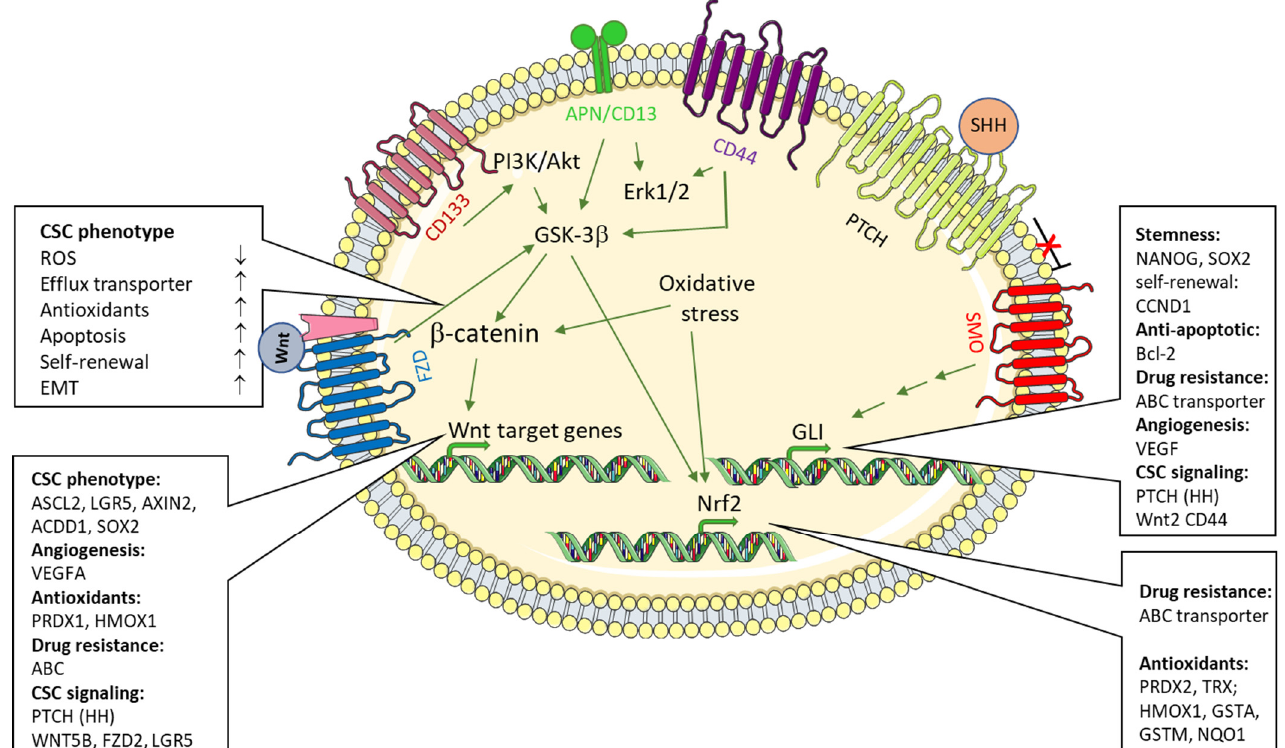
Figure 1. Pathways contributing to the maintenance of the cancer stem cell (CSC) phenotype. Keeping intracellular ROS levels low is required for a stem cell to maintain quiescence and self-renewal properties. This is achieved to a large extent by expression of Nrf2-induced target genes. Thereby, antioxidative defense molecules and detoxifying enzymes including thioredoxin, peroxiredoxin, glutathione-S-transferases, heme oxygenase I are provided to keep the levels of reactive oxygen species derived from, e.g., NADH oxidases (NOX), the respiratory chain, infiltrating/surrounding immune cells, or chemotherapeutic drugs low. Nrf2 and pathways initiated by the CSC surface receptors and markers to minimize ROS production in response to chemotherapeutics like Sonic Hedgehog, Wnt family members, CD13, CD44 or CD133 add to the strong induction of drug efflux transporters. In addition, pathways that contribute to the CSC phenotype act via preventing apoptosis, promoting angiogenesis and expression of stem cell transcription factors such as NANOG homeobox (NANOG HOMEOBOX) and SRY-box transcription factor 2 (SOX2). Note that the canonical β -catenin-dependent Wnt pathway, and GSK-3 β in particular, is a downstream mediator shared by many of the CSC markers and CSC pathways. Arrow up: induced/up-regulated; arrow down: decreases, down-regulated .